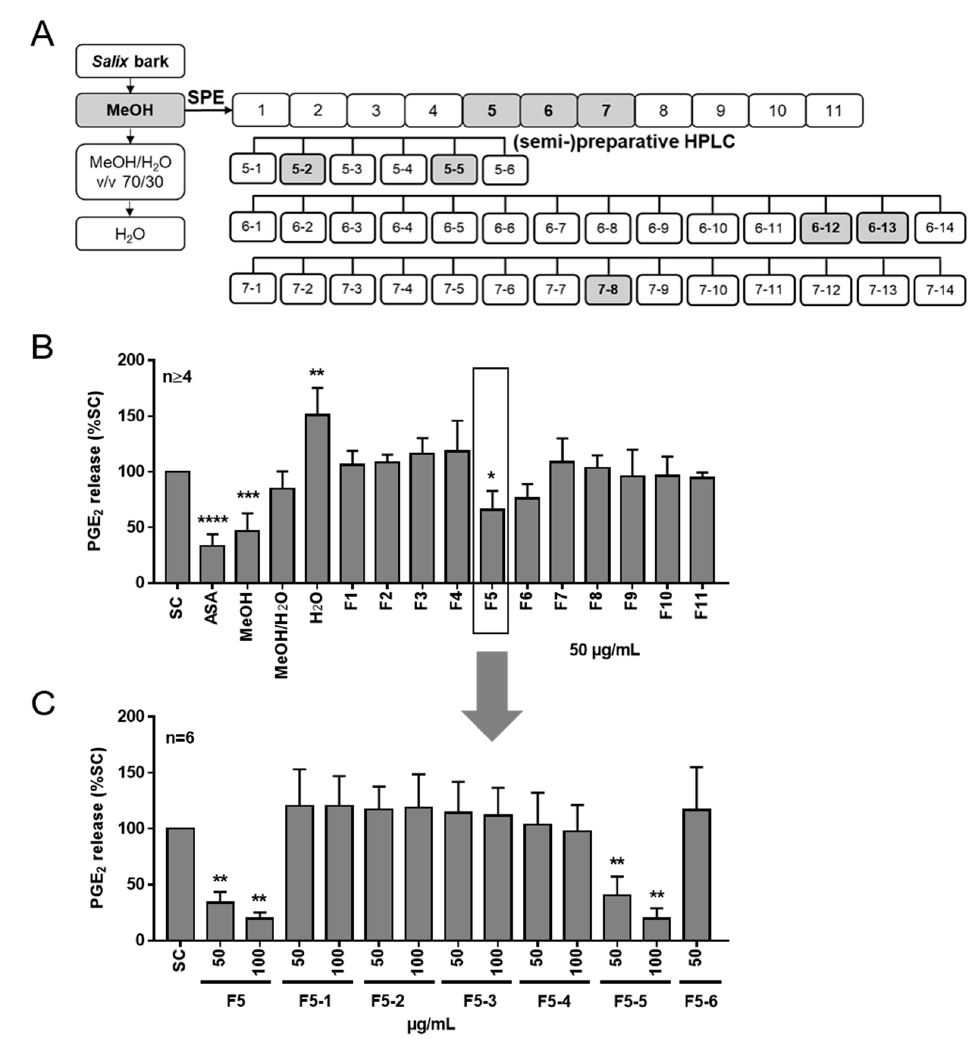
Figure 1. Fractionation scheme and bioactivity of S. pentandra bark extracts and solid-phase extraction fractions. ( A ) The bioactive methanol extract was fractionated using SPE. SPE fraction F5 was further separated by means of (semi)preparative HPLC, and the compounds were subsequently purified and isolated. Grey labeling highlights the extract, SPE fractions, and HPLC fractions from which the purified compounds were isolated. ( B , C ) Inhibition of PGE 2 release from activated human PBMC. Cells were stimulated with LPS for 24 h after a 30 min pretreatment with the extracts, SPE fractions, and subfractions of SPE fraction F5 (F5-1 to F5-6, ( C )) from S. pentandra . Data are the means ± standard deviation (SD.) Asterisks indicate statistically significant differences between the respective treatment and the solvent control. * p < 0.05, ** p < 0.01, *** p < 0.001, and **** p < 0.0001. SC = solvent control (1% dd water, ( B ) and 0.1% DMSO, ( C )). As a reference compound, 1-µg/mL acetyl salicylic acid (ASA) was used ( B ).